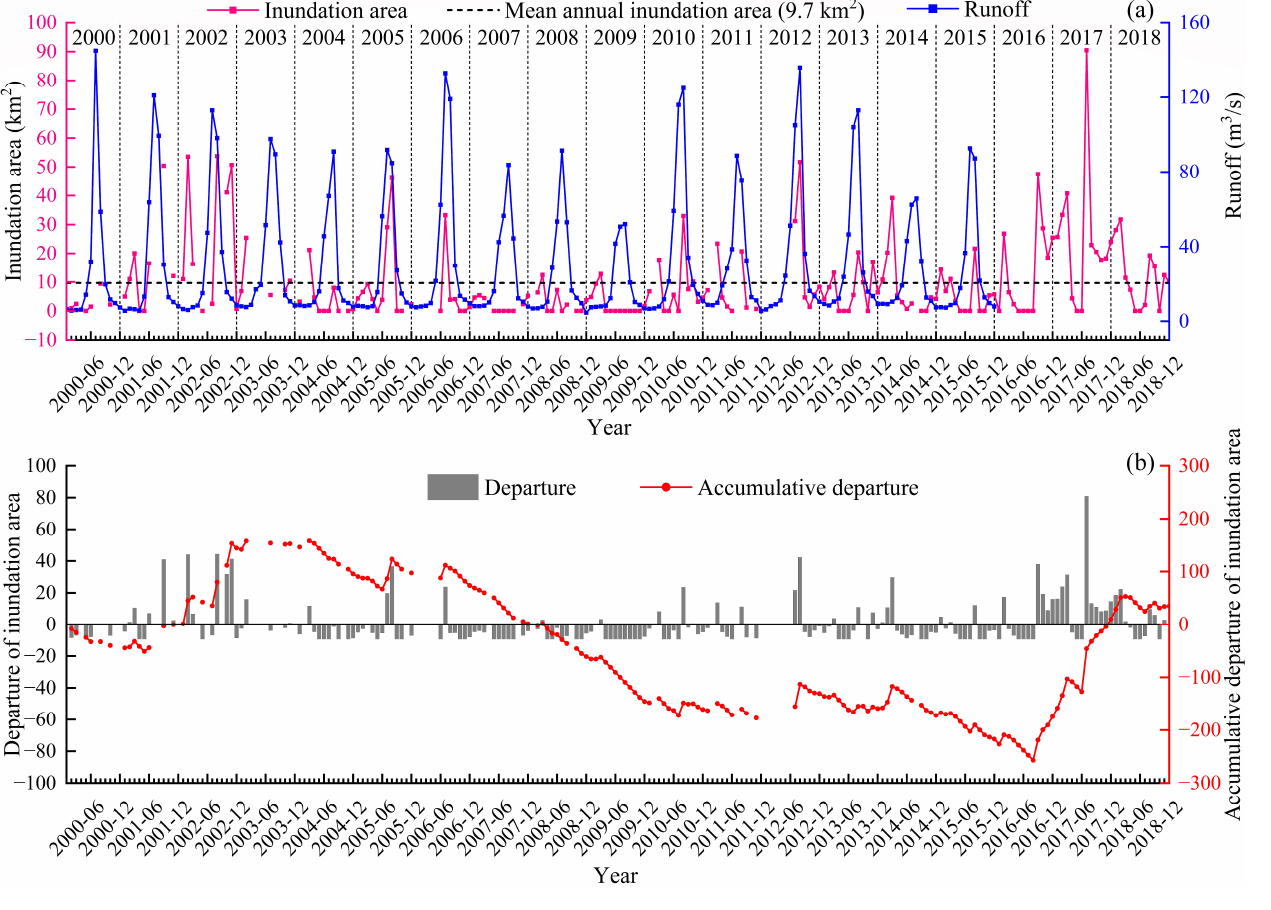
Figure 5. Observed changes in inundation area (2000–2018) measured within the Daliyaboyi Oasis and upstream runoff (2000–2015) within the Keriya River Basin ( a ) and departures and accumulative departure from the mean of inundation area between 2000 and 2018 ( b ). Every tick mark on the horizontal axis ( X -axis) represents one month. The zero value means that the streamflow did not traverse the ephemeral section of the river or its reach within the Daliyaboyi Oasis (i.e., there were no overbank flood events that inundated the